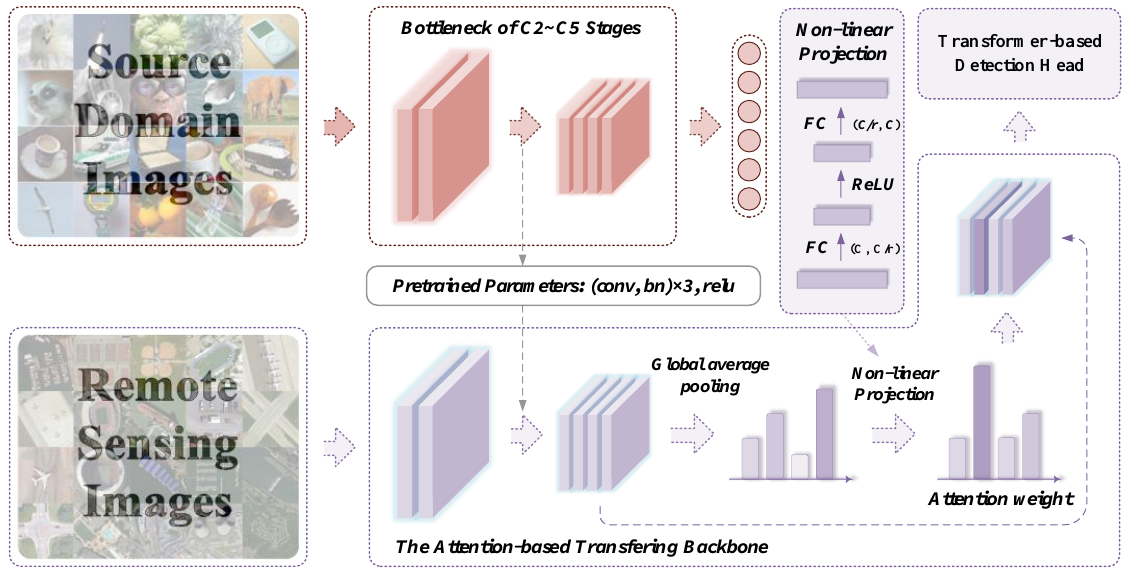
Figure 4. The framework of the proposed attention-based transferring backbone.